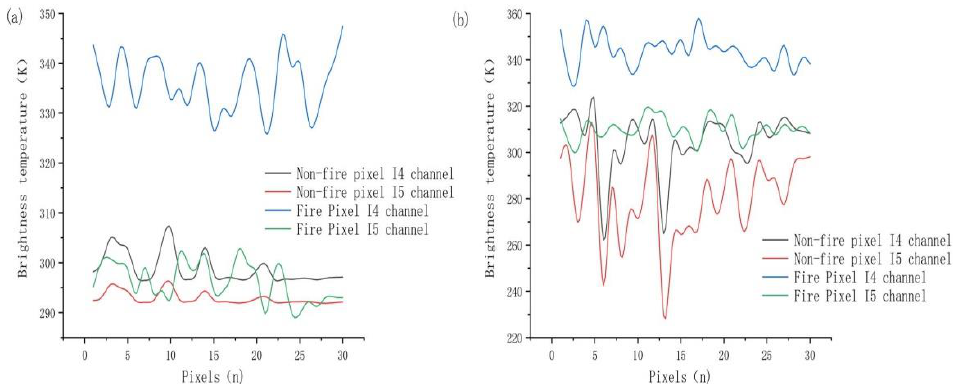
Figure 1. Comparison of brightness temperature between pixel channels I4 and I5. ( a ) Characteristic curve in winter; ( b ) characteristic curve in summer. The horizontal axis represents the case number, and the vertical axis represents the brightness temperature of a typical case.